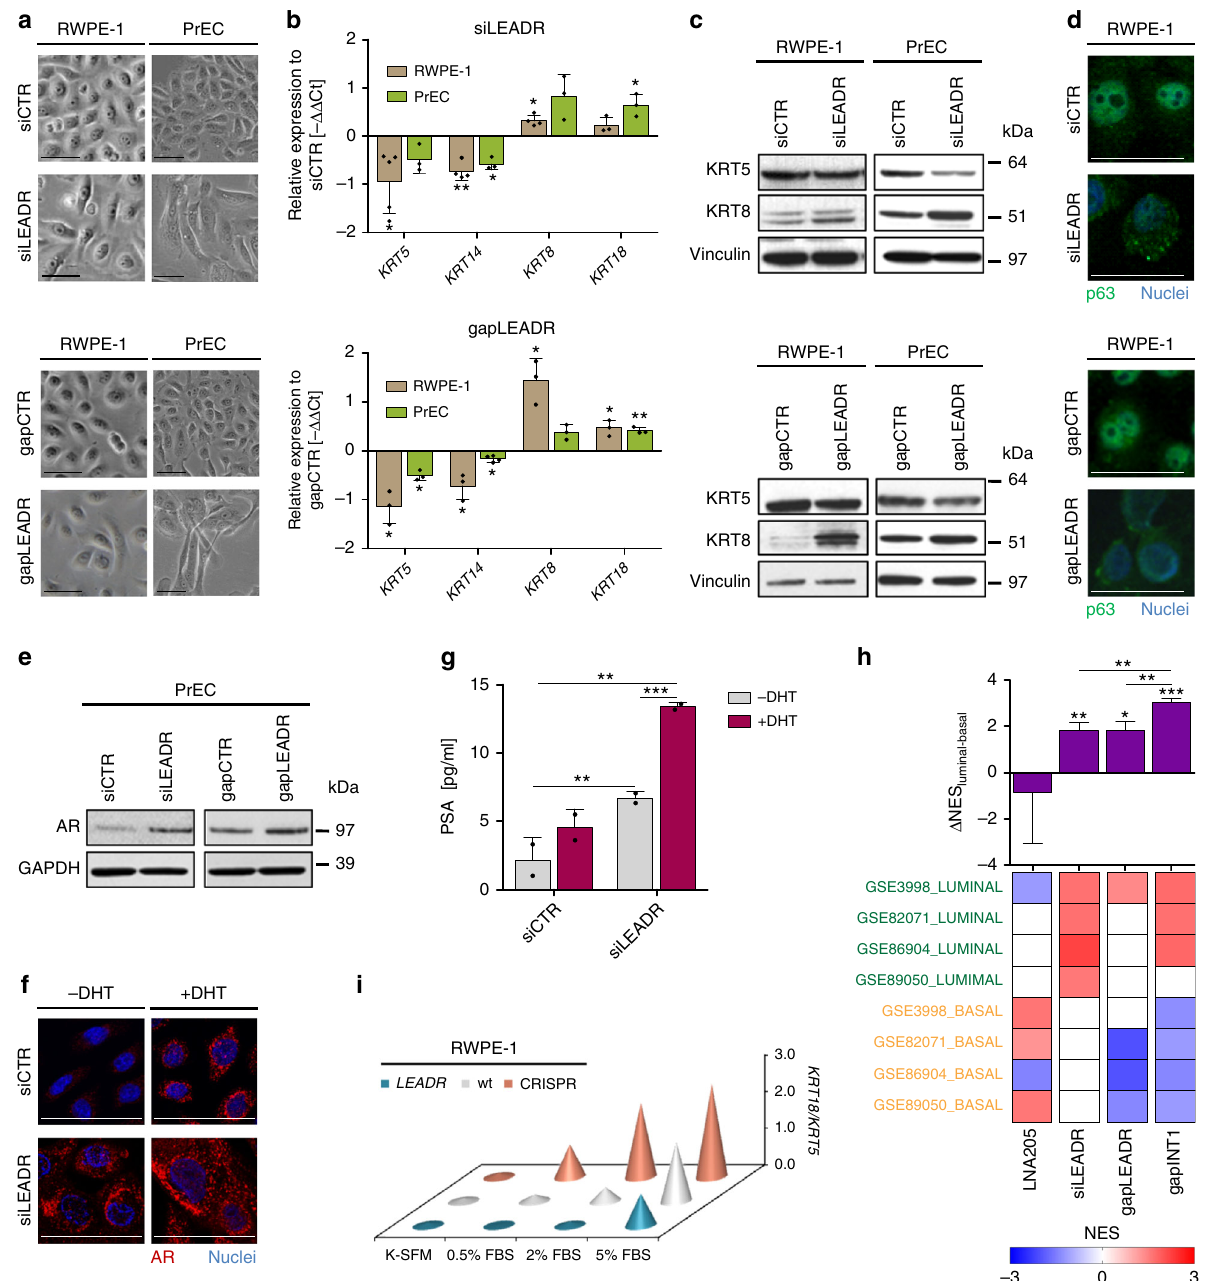
Fig. 5 LEADR regulates basal – luminal differentiation. a Bright- fi eld images showing morphological changes occurring in RWPE-1 ( left ) and PrEC ( right ) cells (day 3) upon LEADR silencing by siLEADR ( top ) or gapLEADR ( bottom ). Scale bar, 50 µ m. Full-size images reported in Supplementary Fig. 4c. b qRT-PCR showing changes in basal and luminal cytokeratins in RWPE-1 or PrEC cells upon LEADR silencing by siLEADR ( top ) or gapLEADR ( bottom ). Mean + s.d. plotted. c Western blots showing changes in basal/luminal cytokeratins in RWPE-1 ( left ) or PrEC ( right ) cells upon LEADR silencing by siLEADR ( top ) or gapLEADR ( bottom ). Vinculin used as loading control. d Immuno fl uorescence showing cytoplasmic re-localization of p63 (green) upon LEADR silencing in RWPE-1 cells by siLEADR ( top ) or gapLEADR ( bottom ). Nuclei counterstained with DAPI (blue). Scale bar, 50 µ m. Full-size images are reported in Supplementary Fig. 4d. e Western blots showing changes in Androgen Receptor (AR) expression in PrEC cells upon LEADR silencing by siLEADR ( left ) or gapLEADR ( right ). GAPDH used as loading control. f Immuno fl uorescence showing AR (red) expression in PrEC cells upon LEADR silencing by siLEADR, in the presence or absence of simultaneous DHT stimulation. Nuclei counterstained with DAPI (blue). Scale bar, 50 µ m. Full-size images reported in Supplementary Fig. 4g. g ELISA-based quanti fi cation of PSA in the conditioned media of PrEC cells silenced for LEADR expression by siLEADR (±DHT). Mean + s.d. ( n = 2) plotted. h Heatmap ( bottom ) of the normalized enrichment score (NES) for luminal and basal custom gene sets (obtained from gene- expression data of frankly basal and luminal prostate cells from the indicated datasets) in RWPE-1 cells upon knockdown of LEADR and/or miR-205 (the latter abrogated using an antisense LNA-modi fi ed oligomer, LNA205). Bar plot of differential luminal/basal NES is reported ( top ). Mean + s.d. ( n = 4) plotted. i Plot showing propensity of wild type (wt), LEADR -overexpressing and CRISPRed RWPE-1 cells to differentiate toward luminal phenotype (measured by qRT-PCR and expressed as KRT18/KRT5 ratio) upon culturing in media with increasing differentiative potential ( n = 3). ∗ p < 0.05; ∗∗ p < 0.01; ∗∗∗ p < 0.001 (Student ’ s t test). Source data are provided as a Source Data fi le, together with n of all